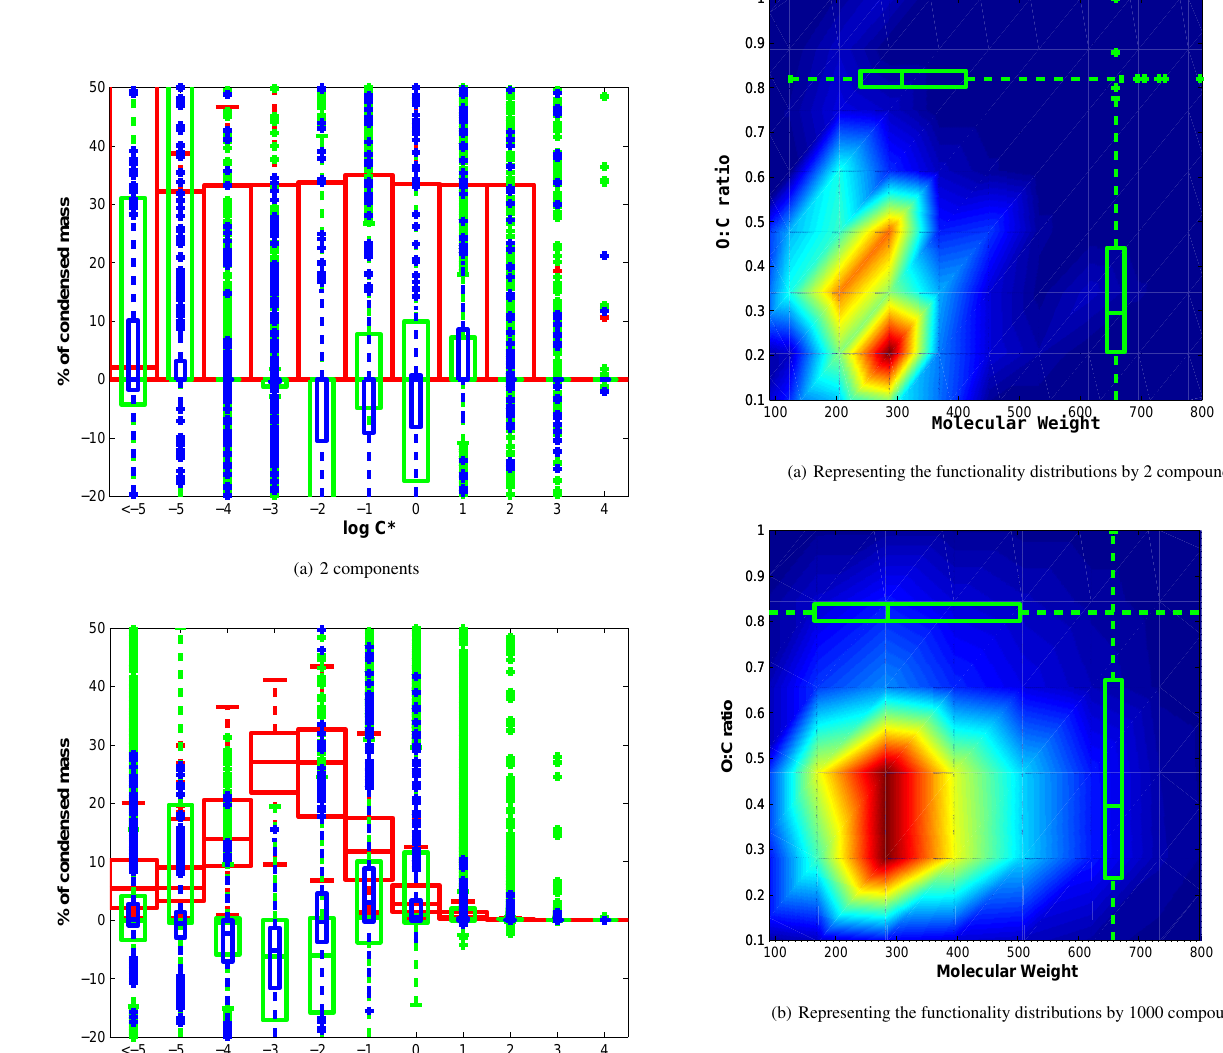
Fig. 8. Predicted frequency distribution of normalised mass- weighted average O:C ratio and M w for each of 1000 simulations using the base N-N/VP method in the partitioning model, with units of normalised frequency in each bin of 0.05 in O:C and 50 gMol − 1 in M w . Fig. 7. Sensitivity of the volatility distribution, in terms of the vari- ability in % contribution to total condensed mass, to changes in predictive technique across all 1000 functionality sets. The red bars show the range of volatility of the components in the base case as a percentage of the condensed SOA mass. The green and blue box and whiskers both show relative change in the percentage contri- bution to the total SOA mass from each bin referenced to the base case; the blue symbols do not consider variations resulting from use of the JR T b technique whereas the green do. The choice of techniques shifts the distribution of condensed material in differ- ent volatility bins, with a smaller systematic difference to the base case when the JR technique is not used. Note the large bias towards components in the log ( C ∗ i ) = -5 bin when JR is used.